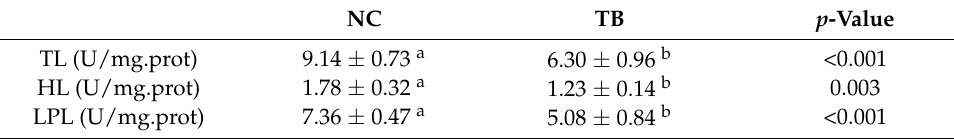
Table 4. Effect of TB on liver lipid parameters in broiler chickens.